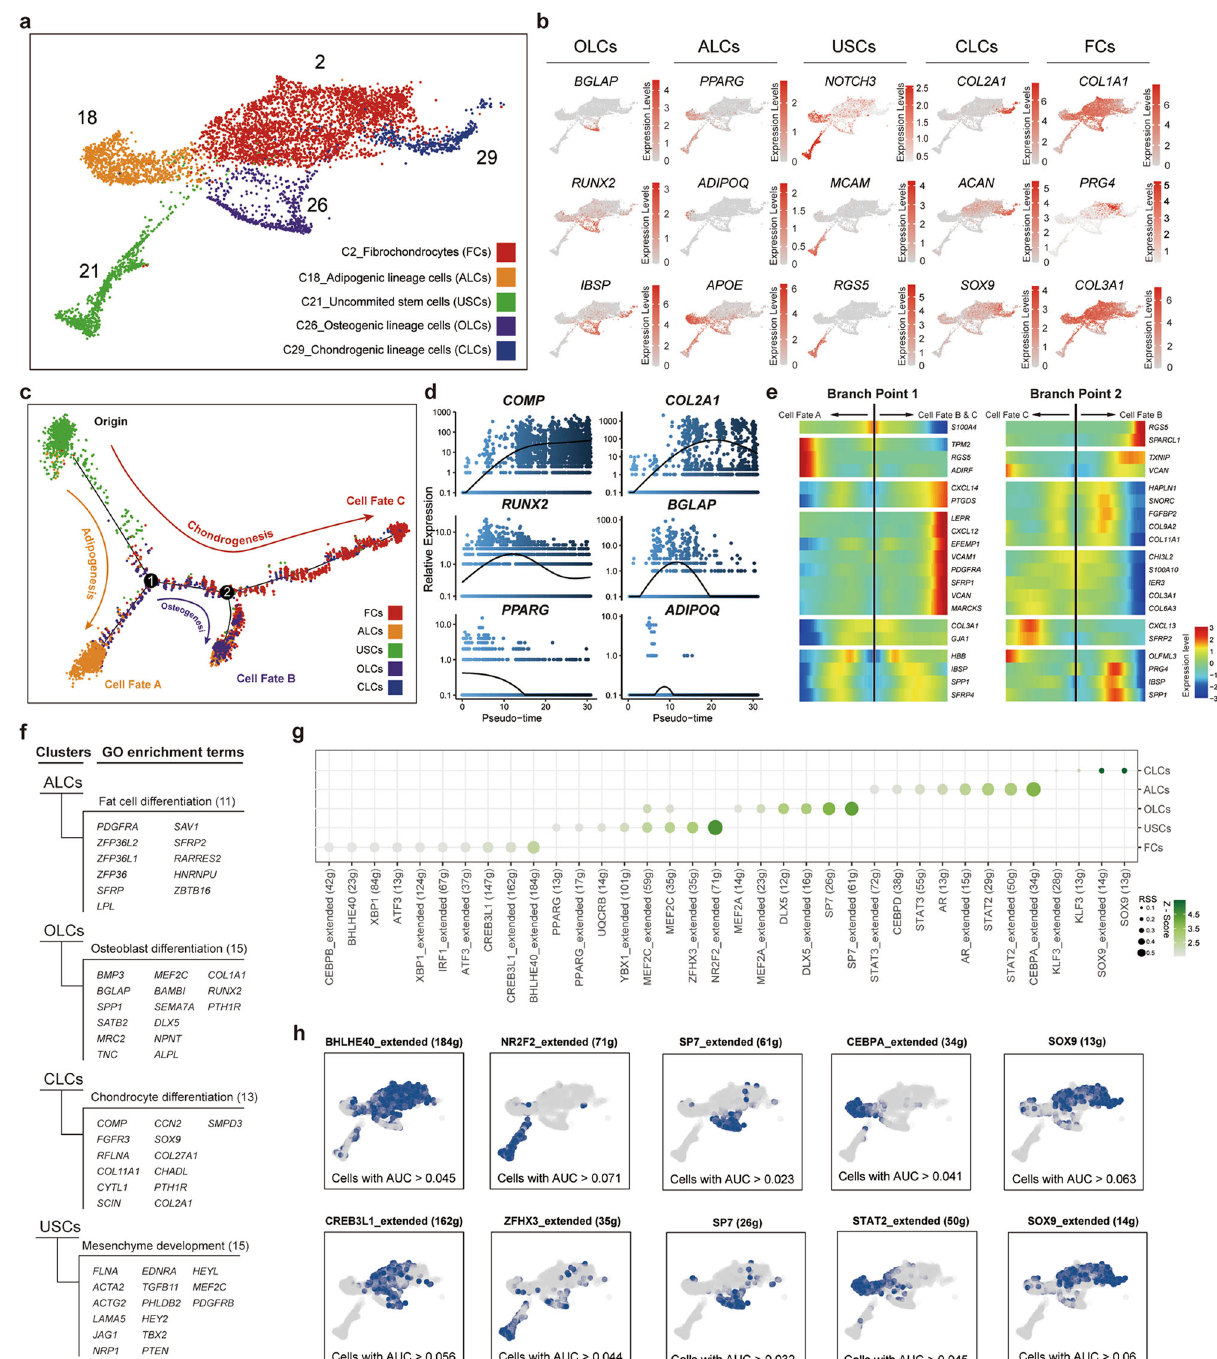
Fig. 2 Characterization of stromal cells in alcohol-induced ONFH. a UMAP showing the clustering and annotation of stromal cells. b Feature plots showing the distribution of recognized lineage-speci fi c genes. c Trajectory map indicating the developmental correlations of the 5 SC clusters. d Lineage- speci fi c gene expression changes over pseudotime. e Heatmap showing the top 10 DEGs between different cell fates at development node 1 and node 2 in ( c ). f Differentiation-related GO terms enriched by the top 100 DEGs of each SC cluster. The numbers and names of the enriched genes are listed behind and below the GO terms, respectively. g Bubble plot showing the Regulon speci fi city score (RSS) of each SC cluster ’ s highly speci fi c regulons. h Feature plots showing the binary regulon activity scores of the two regulons with the highest RSSs in each SC cluster. AUC: area under the